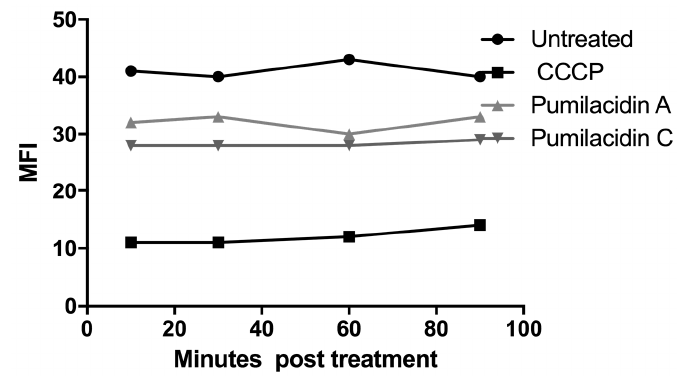
Figure 9. Kinetic measurement of cytosolic Ca 2+ . Saponin-isolated parasites stained with fura-2-acetoxymethyl ester (FURA 2AM) were treated with pumilacidins A and C at a concentration of 10 µ M. Untreated parasites were used as controls. Readings were taken at 10, 30, 60, and 90 min after pumilacidin introduction. Samples were tested in duplicate. A representative result is